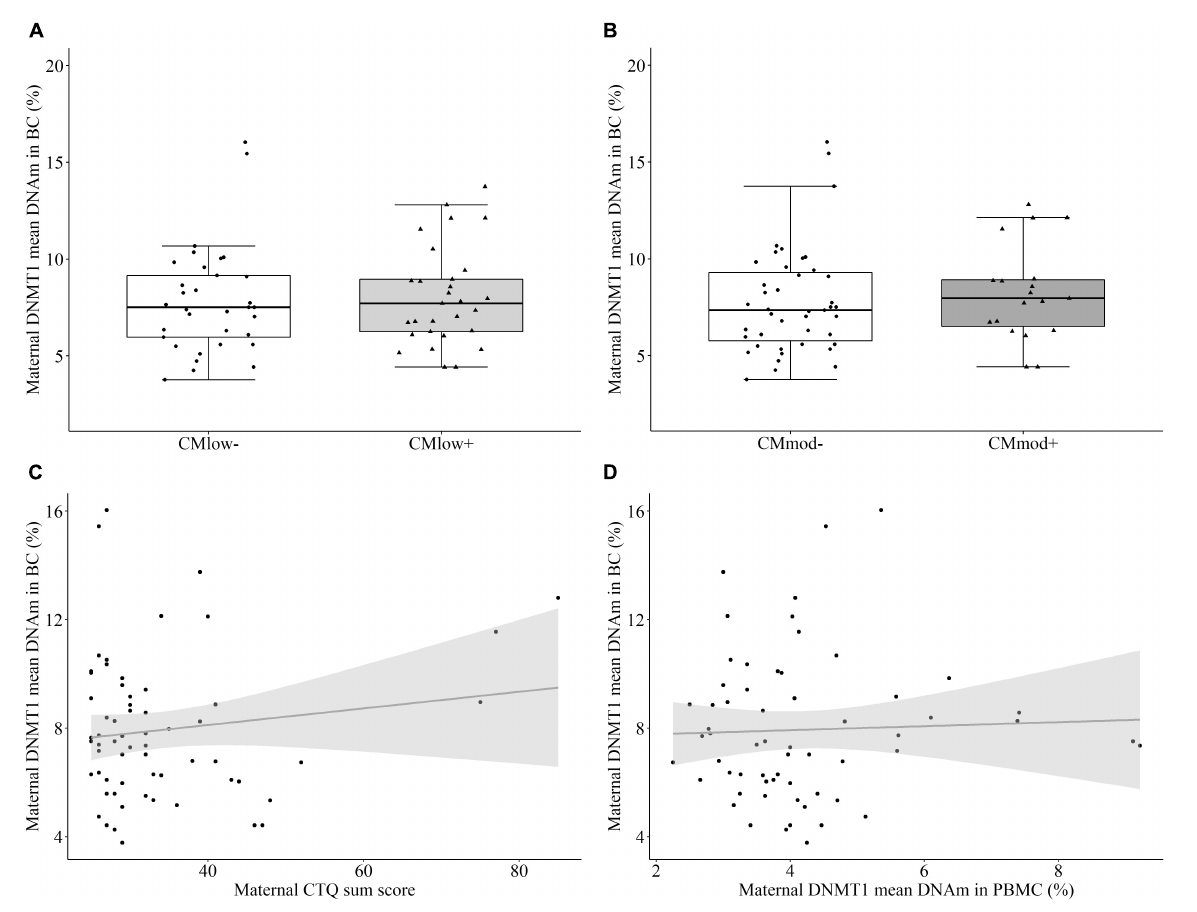
FIGURE4 DNA methyltransferase 1 (DNMT1) mean DNA methylation (DNAm) in buccal cells (BC) of the mothers. (A,B) DNMT1 mean DNA methylation did not differ in mothers categorized with their childhood maltreatment (CM) experiences depending on the low cut-off (CM low - versus CM low + )